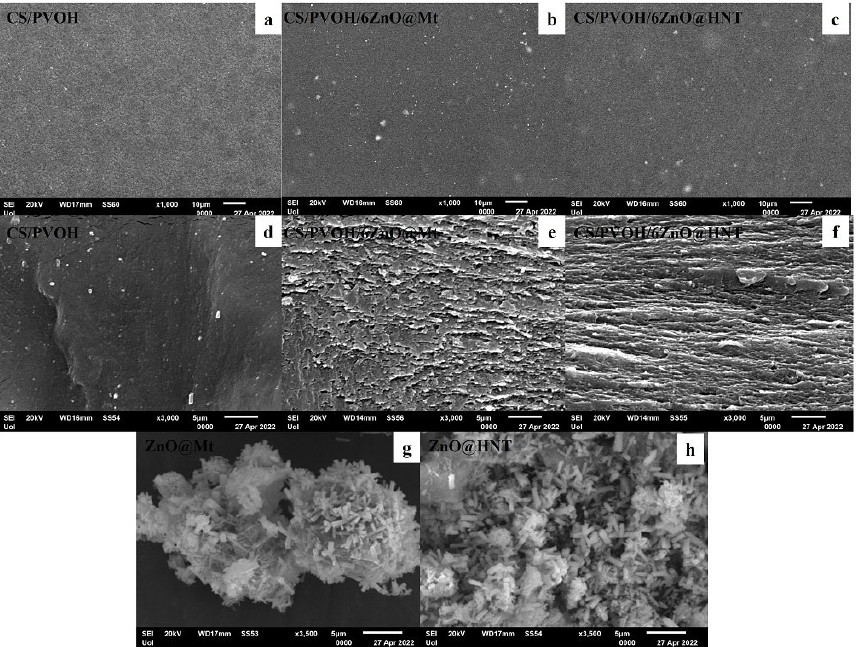
Figure 4. SEM images of surface and cross ‐ section for the films: ( a , d ) CS/PVOH, ( b , e ) CS/PVOH/6ZnO@Mt, and ( c , f ) CS/PVOH/6ZnO@HNT. Surface images of nanohybrids ( g ) ZnO@Mt and ( h ) ZnO@HNT. SEM images.